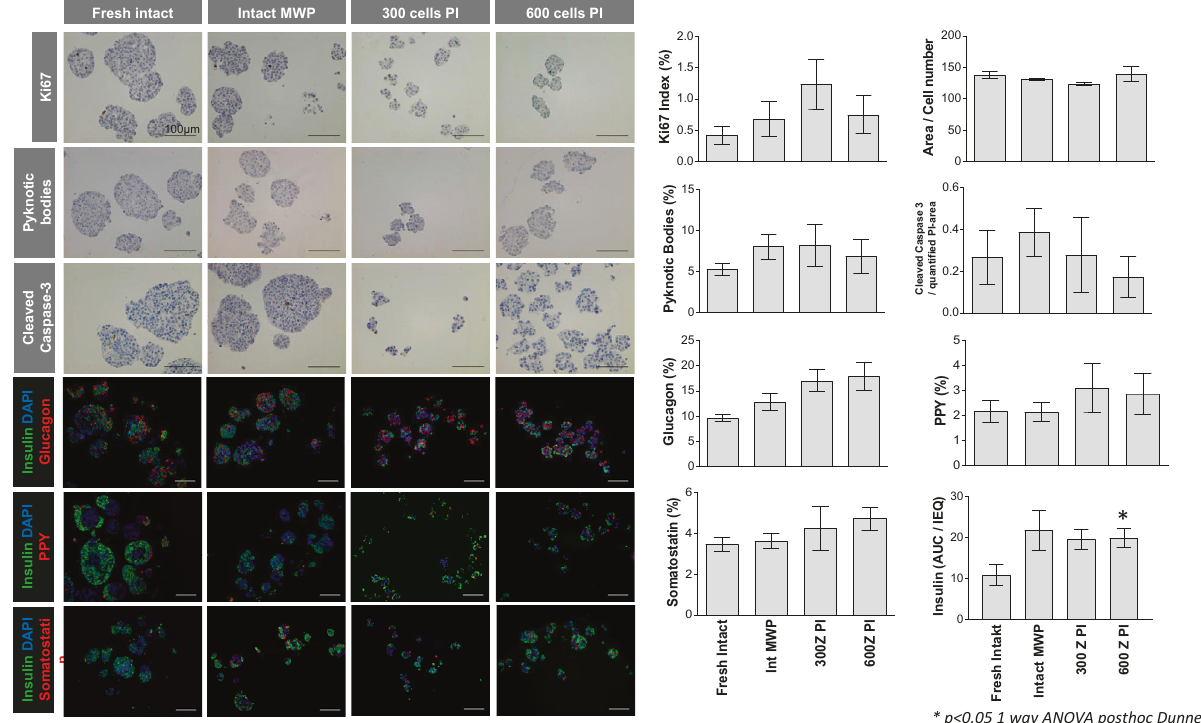
Fig. 2 Freshly isolated islets were either cultured intact (fresh islets), in multiwell plates (Intact MWP) or dissociated to form pseudoislets (PI) constituting of 300 cells (300 cells PI) or 600 cells (600 cells PI). Islets or pseudoislets from each condition were processed for IHC for various markers, scale bar 100 um. Cells positive for the markers were counted and reported as percentage of all cells. Data obtained from 10 individuals ( n = 10; including furthermore quanti fi cations from three high power fi elds per individual) is reported as mean + / − sem and was analyzed by ANOVA with Dunnett test * p <